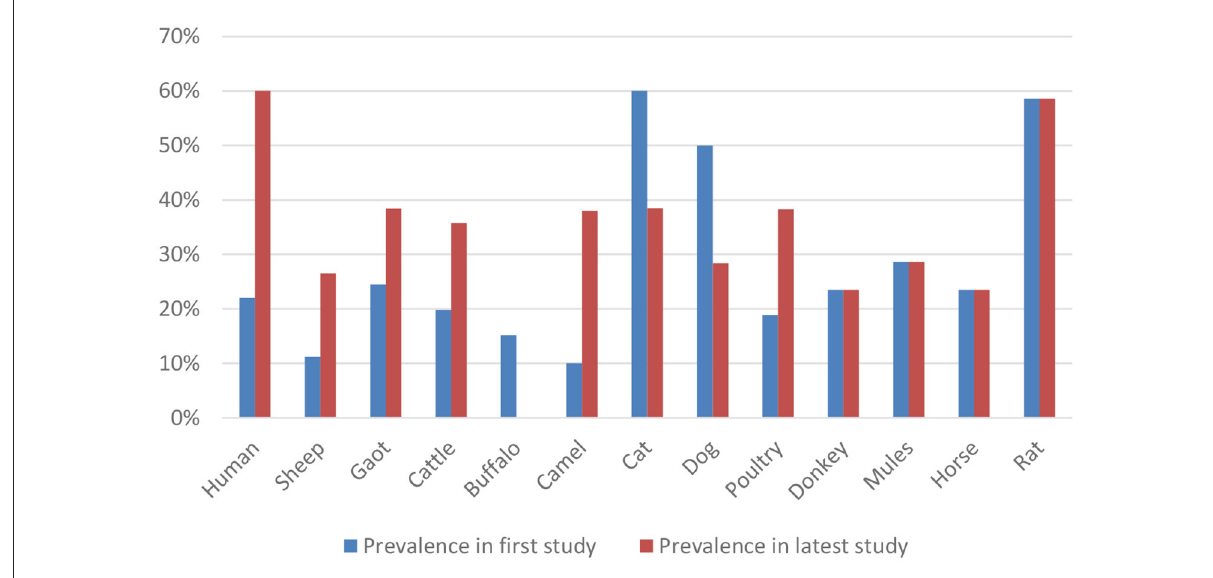
FIGURE3 Comparison of prevalence rate of Toxoplasma gondii between the first and the latest